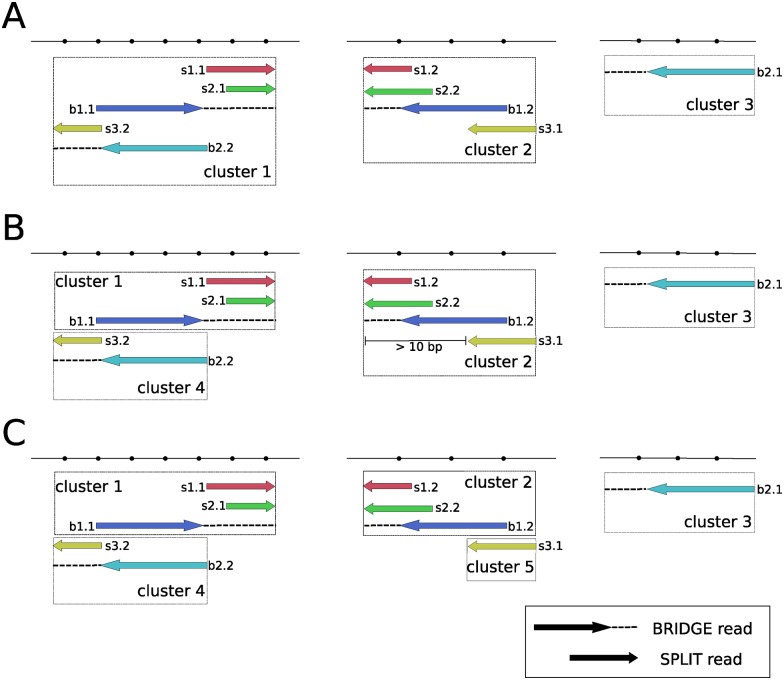
Clustering of breakpoint candidates.The arrows of the SPLIT alignments and the dot lines of BRIDGE alignments demonstrate the direction to the breakpoint position. (A) Initial clusters are created from intersecting SPLIT and BRIDGE alignments. (B) Cluster 4 is separated from cluster 1 based on the directionality, which is inferred from the alignment strand and order. (C) Cluster 5 is separated from cluster 2 based on the putative breakpoint position. Alignments belonging to the same breakpoint candidate have the same color. BRIDGE reads are marked with b, SPLIT reads are marked with s. A SPLIT read assumes an exact breakpoint, while a BRIDGE read assumes an approximate breakpoint within allowed insert size distance.